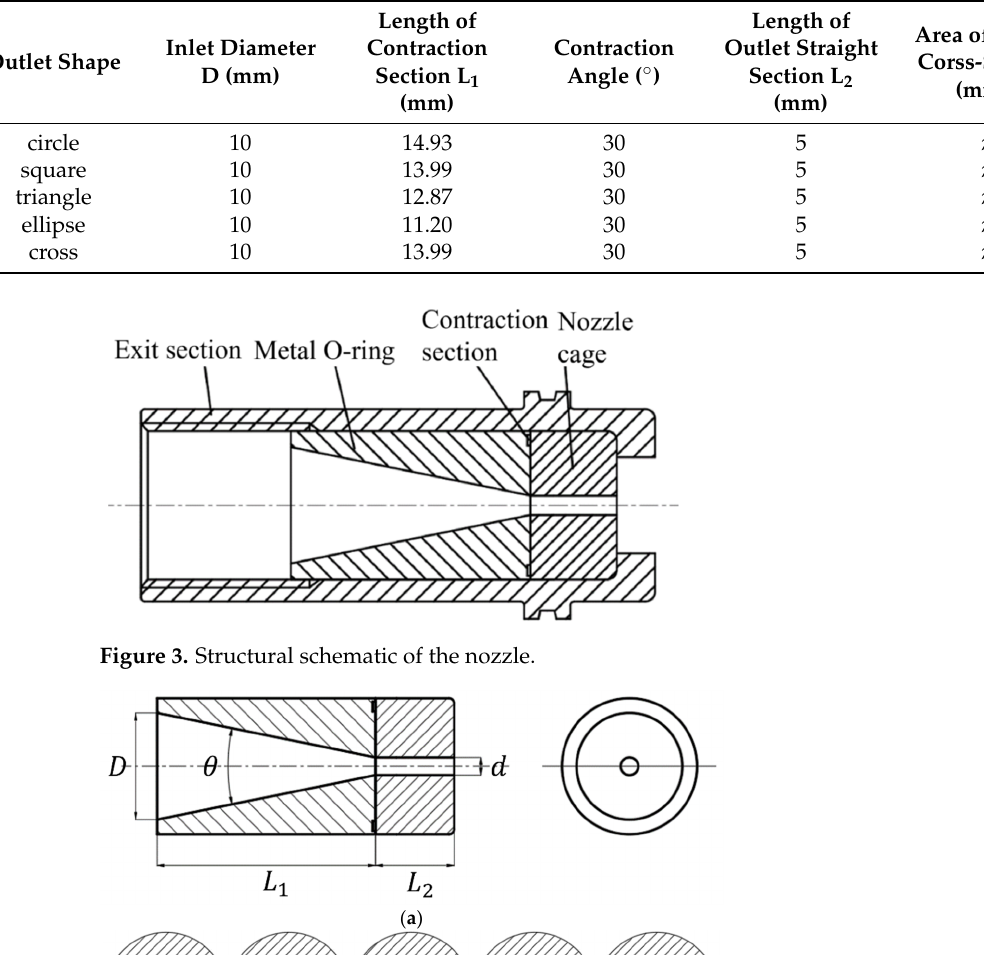
Table 2. Structural parameters of the nozzle.